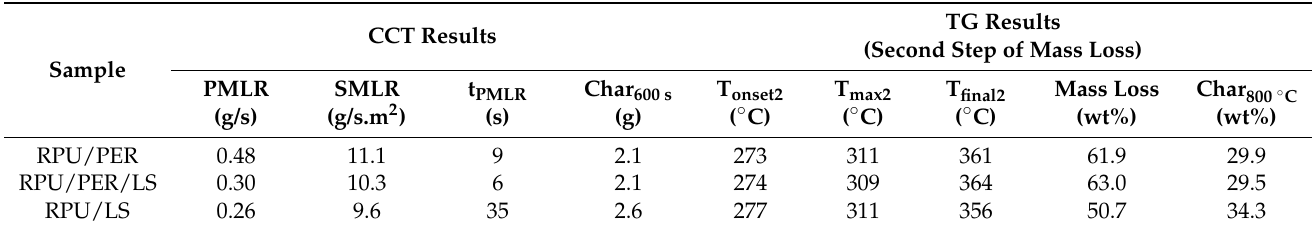
Table 5. Effect of LS as a char forming agent on mass loss.